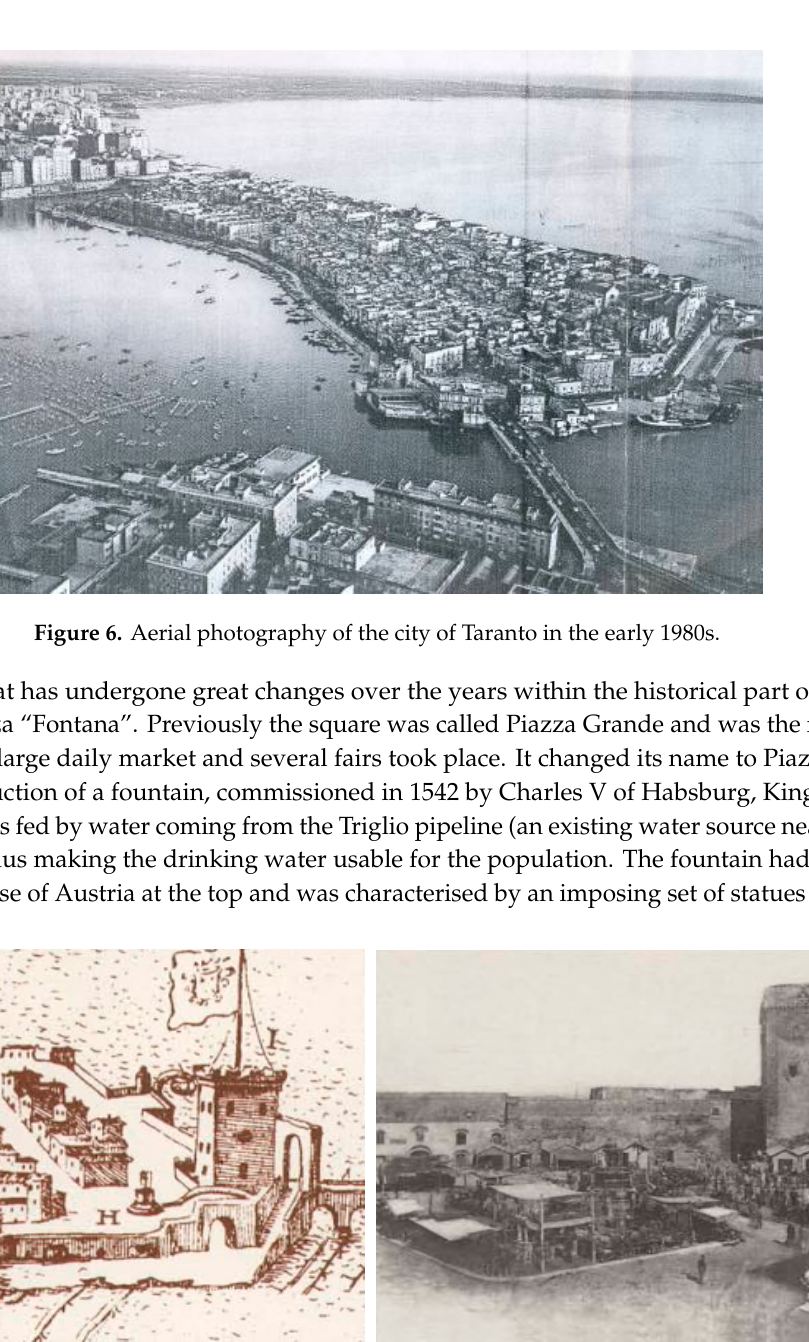
Figure 7. Iconographic reconstruction of Piazza Fontana: ( a ) the square in 1703; ( b ) in 1893.